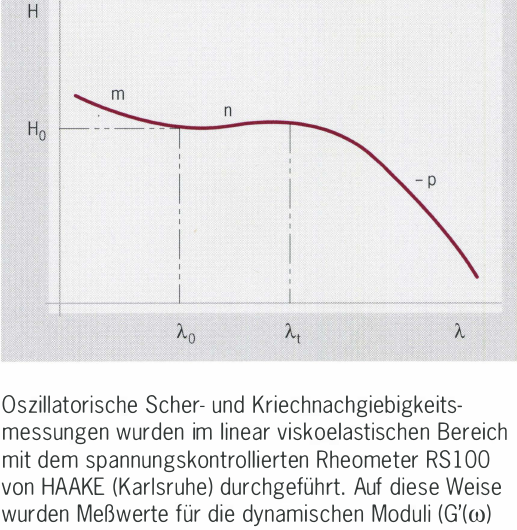
as a function of oil concentration for the emulsions containing 5 % wt emulsifier, at 25